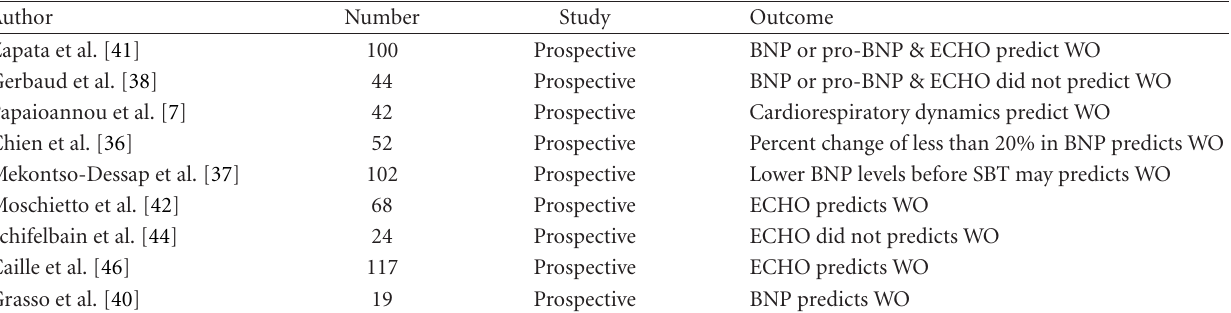
Table 1: Prediction of respiratory weaning outcomes.